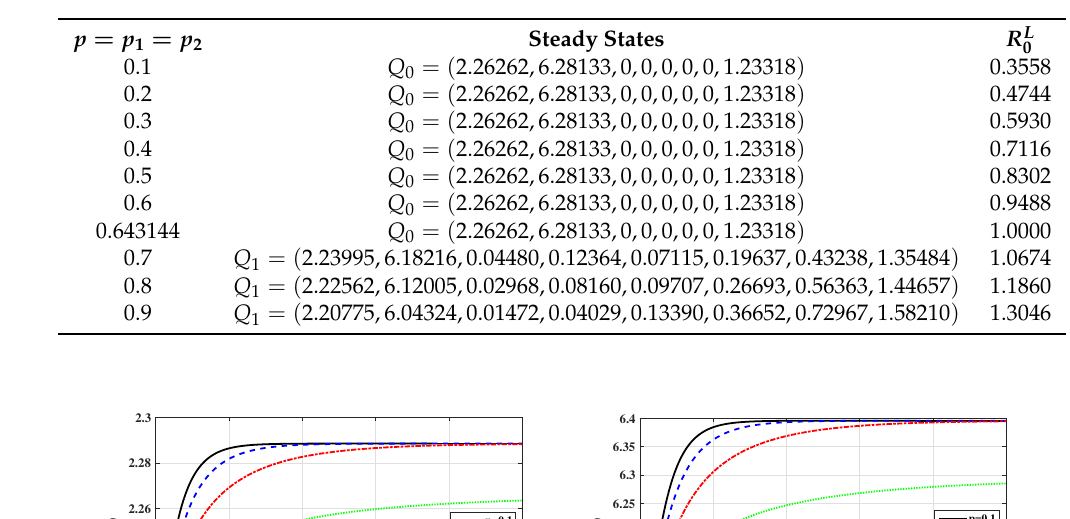
for the model in Equations (19)–(23) with different values of p . 0